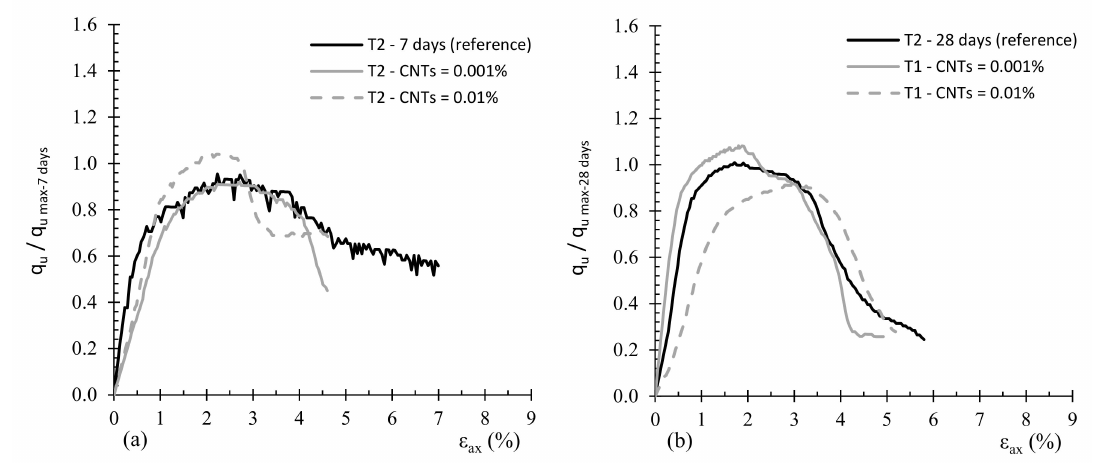
Figure 6. Stress–strain normalized curves for the stabilized soil additivated with MWCNTs and no surfactant for samples with ( a ) 7 curing days and ( b ) 28 curing days.